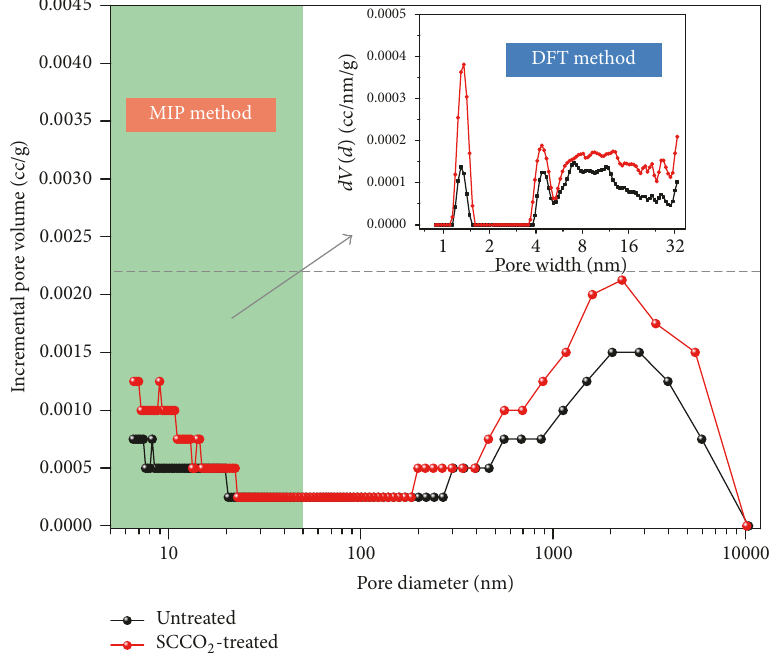
Figure 6: Pore size distribution of untreated and SCCO 2 -treated coal from the MIP and DFT method.